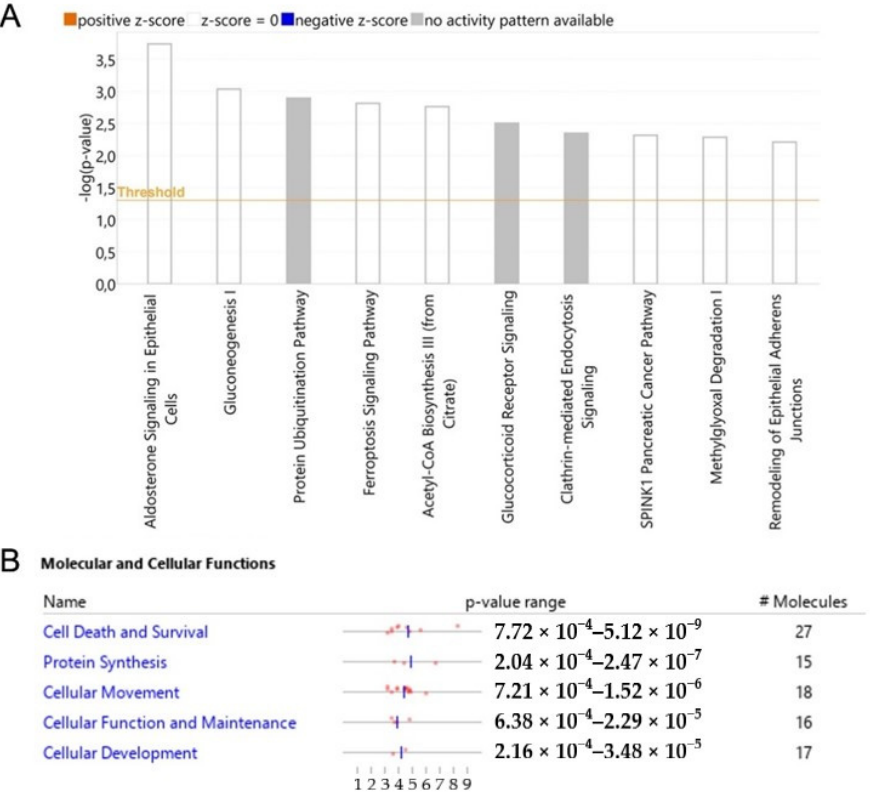
Figure 5. p53-driven canonical pathways and molecular and cellular functions. Bar-plot of canonical pathway significance ( − log( p -value)) of altered secreted proteins in response to the silencing of p53 in PDAC ( A ). Activation/inhibition (z-score) was not predicted. Molecular and cellular functions with significance ( p -value) and number of associated proteins ( B ).